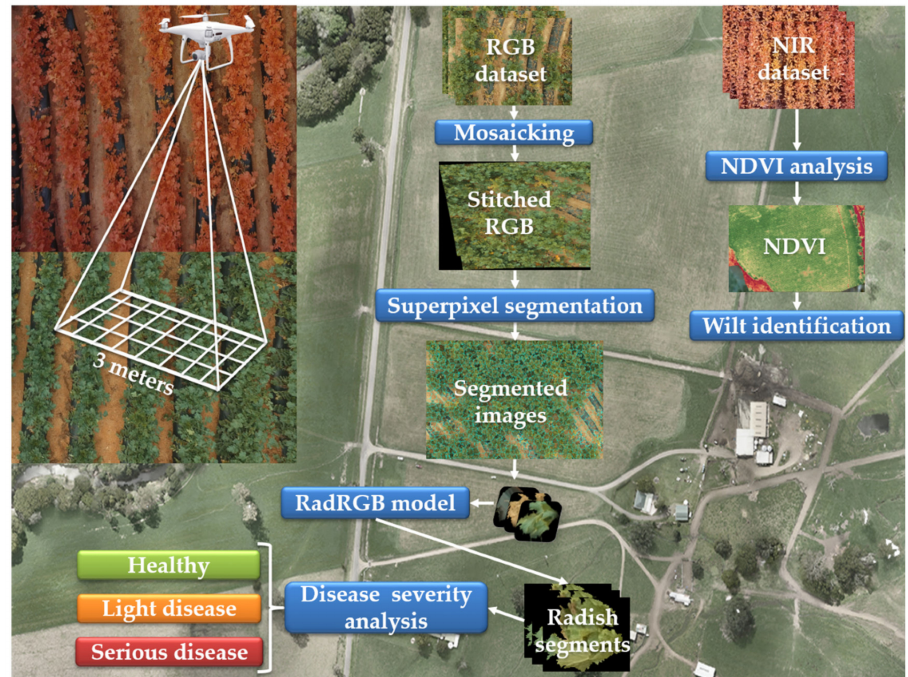
Figure 4. Overall structure of the proposed wilt detection framework. Two UAV were used to capture the RGB and the NIR images at the 3-m altitude. After that, two distinctive sub-processes were implemented to perform radish wilt detection on the RGB and the NIR